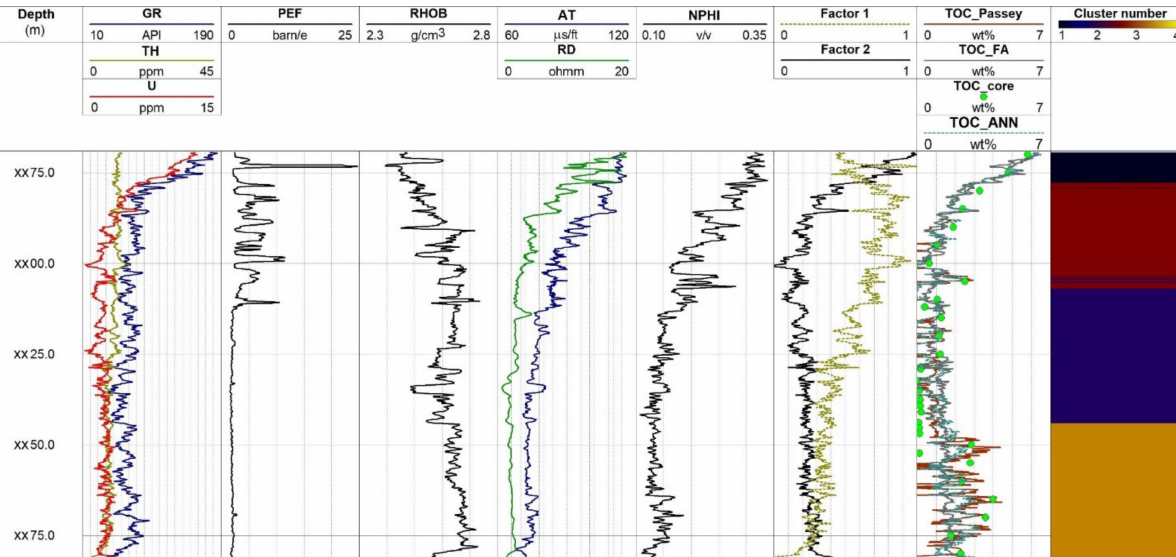
Figure 5. Result of factor analysis in Well C. Denotations are are follows: natural gamma-ray (GR), thorium concentration (TH), uranium concentration (U), photoelectric absorption factor (PEF), bulk density (RHOB), acoustic travel-time (AT), deep resistivity (RD), neutron porosity (NPHI), first factor (Factor 1), second factor (Factor 2), TOC estimates from Passey’s method (TOC_Passey), TOC estimates from the factor analysis (TOC_FA), TOC estimates of artificial neural network (TOC_ANN) and TOC estimates measured on core samples (TOC_core). The last track shows the depth distribution of four identified